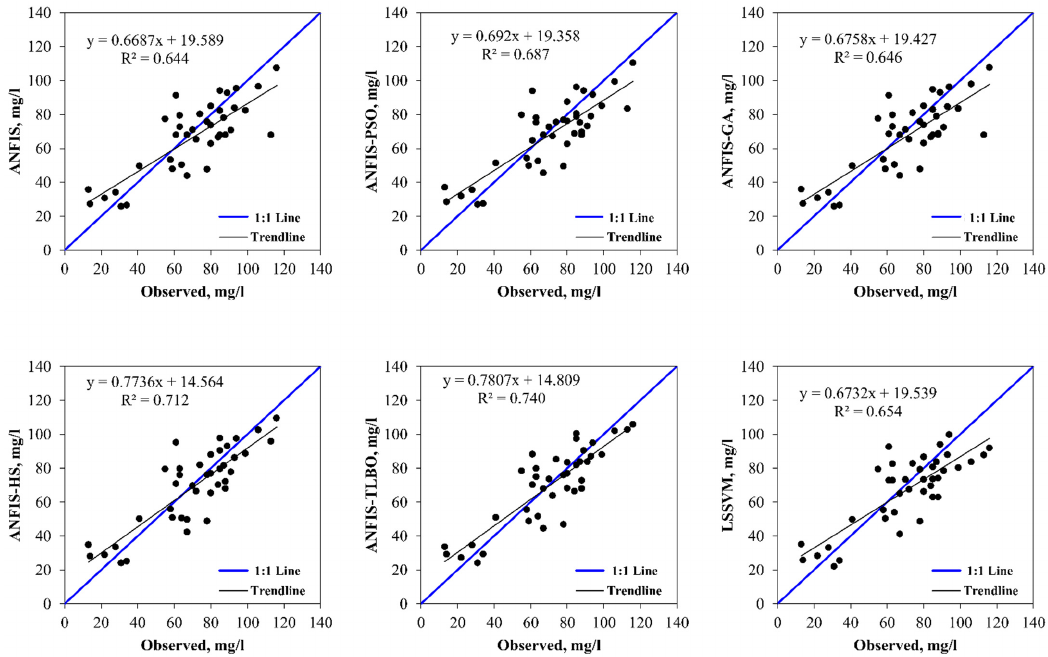
Figure 6. The observed and model-estimated CODs for the M2 data set with all variables as input.